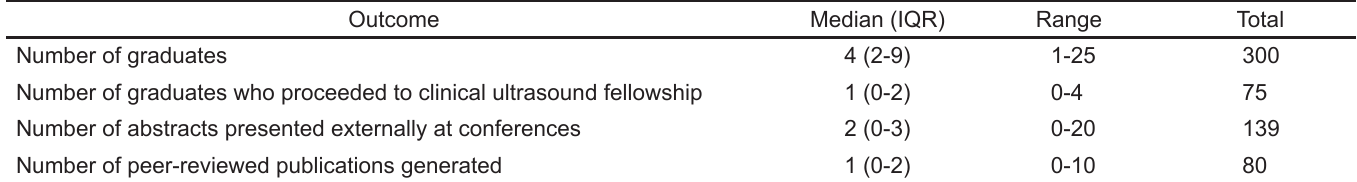
Table 5. Outcomes of point-of-care ultrasound scholarly tracks over the past three academic years (n = 57).